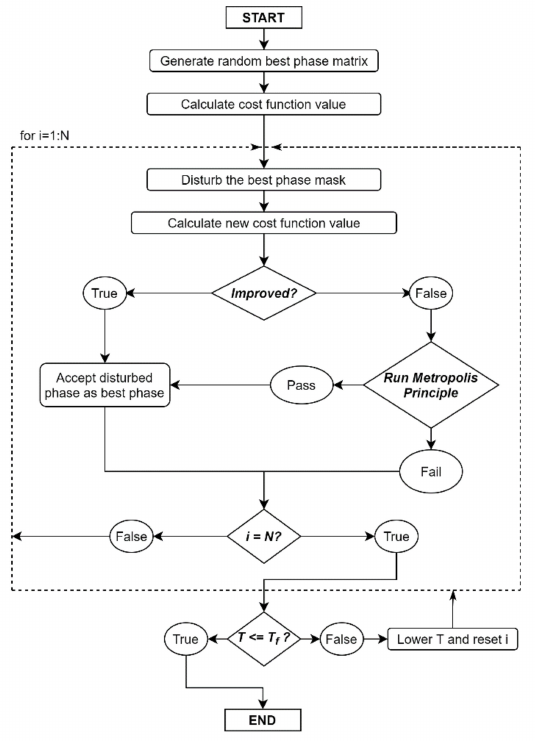
Figure 3. SAA principle’s